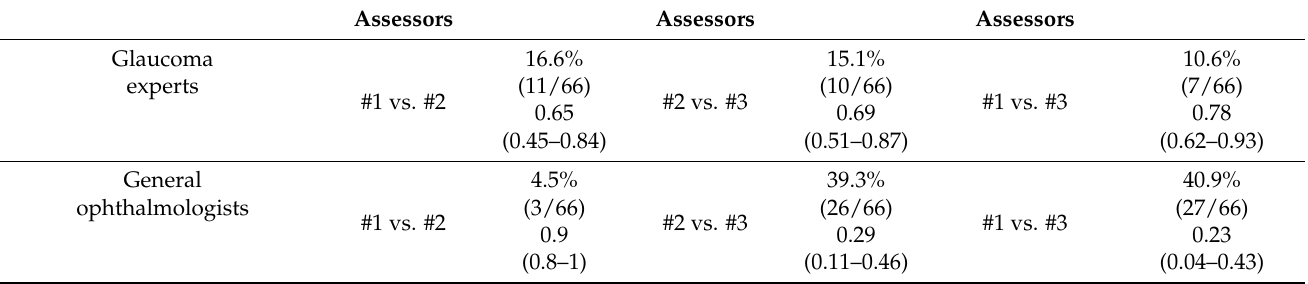
Table 3. Percentage of VF series with discordant opinion and k statistics with 95%CI between each pair of assessors among glaucoma experts and general